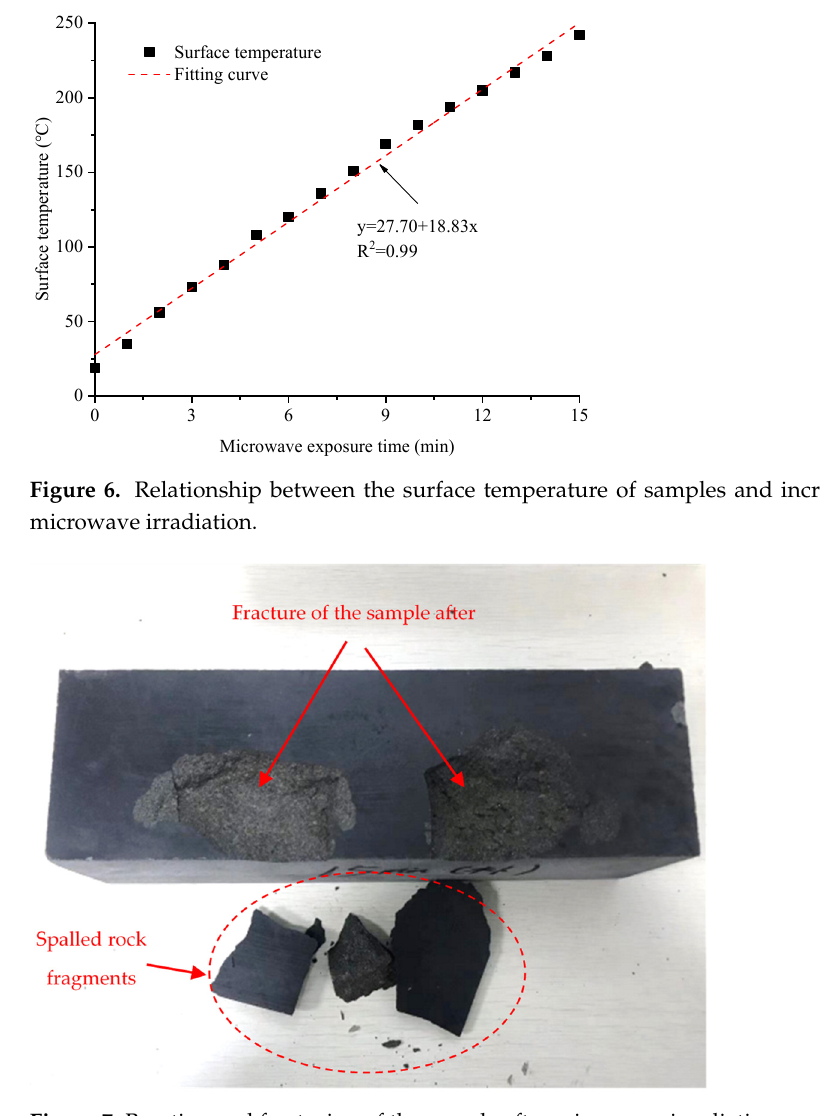
Table 1. Changes in the mass loss of the reduced-scale TBM cu tt er with increasing exposure to mi- crowave irradiation.